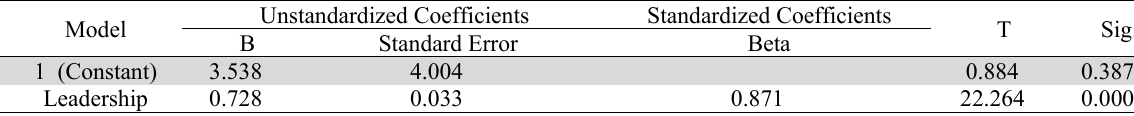
Coefficient job satisfaction and performance